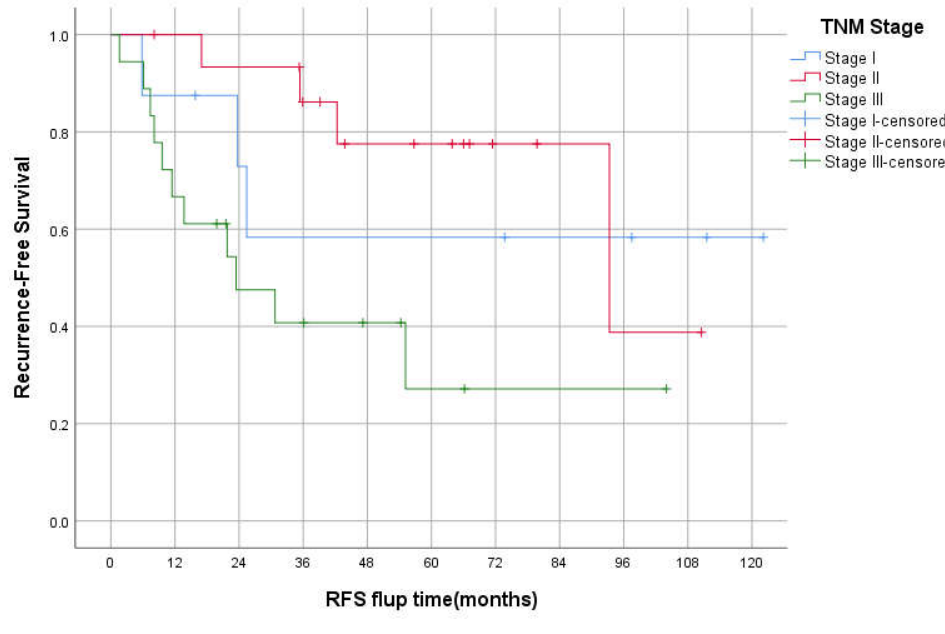
Figure 2. Kaplan–Meier curve of Overall Survival based on TNM Staging.